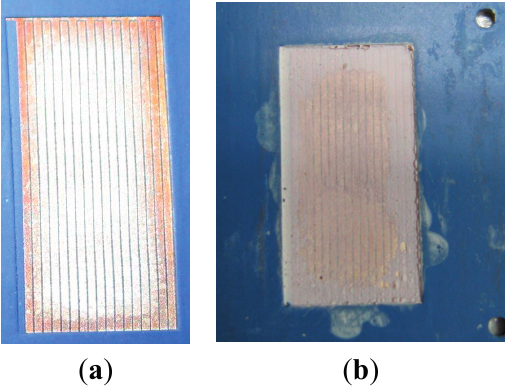
Figure 8. ( a ) The enlarged image of interdigitated capacitor before the deposition of the BBT film; ( b ) The visual appearance of the sensor after the deposition of the BBT